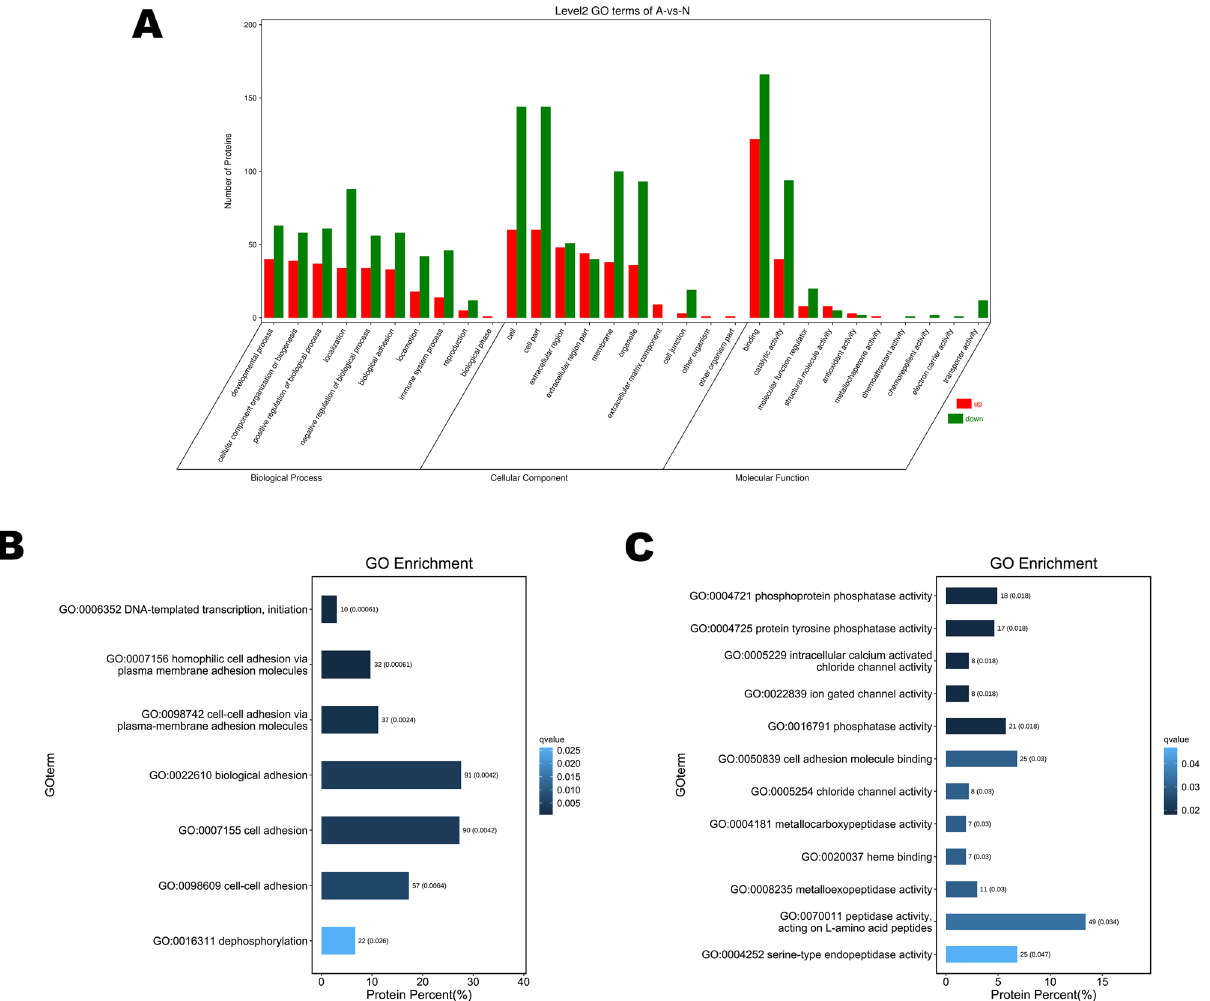
Figure 3. Functional analysis of urinary proteins between group N and group A. ( A ) GO enrichment analysis of differentially expressed proteins identified in urine samples of neonatal donkeys and adult donkeys. Proteins were divided into three categories including biological process, cellular component, and molecular function. ( B ) The most differentiated activities in biological process category identified between group N and group A. ( C ). The most differentiated activities in Metabolic function category identified between group N and group